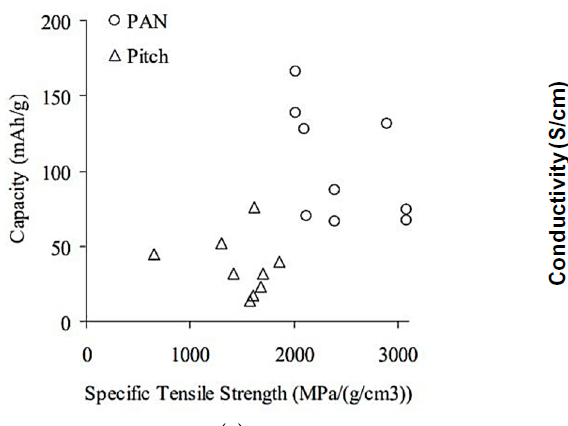
Figure 6. Structural battery scheme.